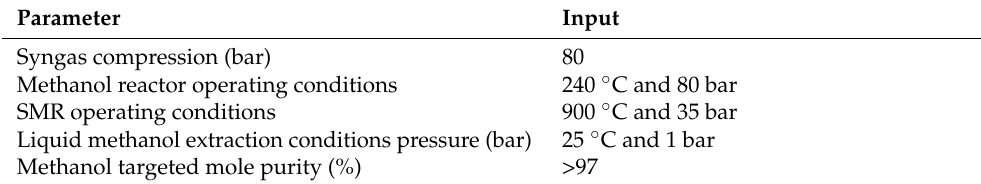
Table 6. Methanol synthesis unit process